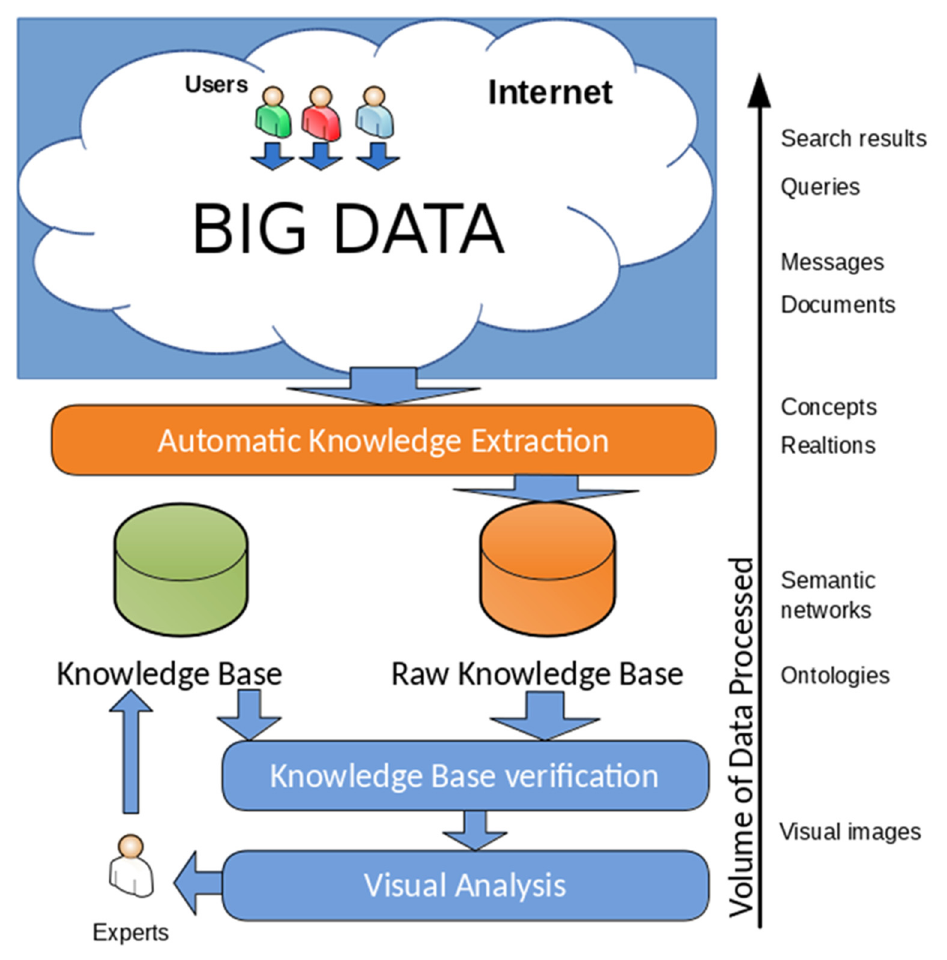
Figure 3. Information technology for knowledge base creation.